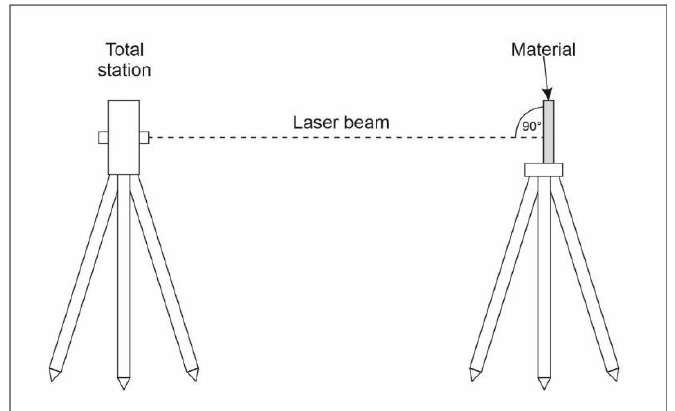
Figure 1. The experimental setup.